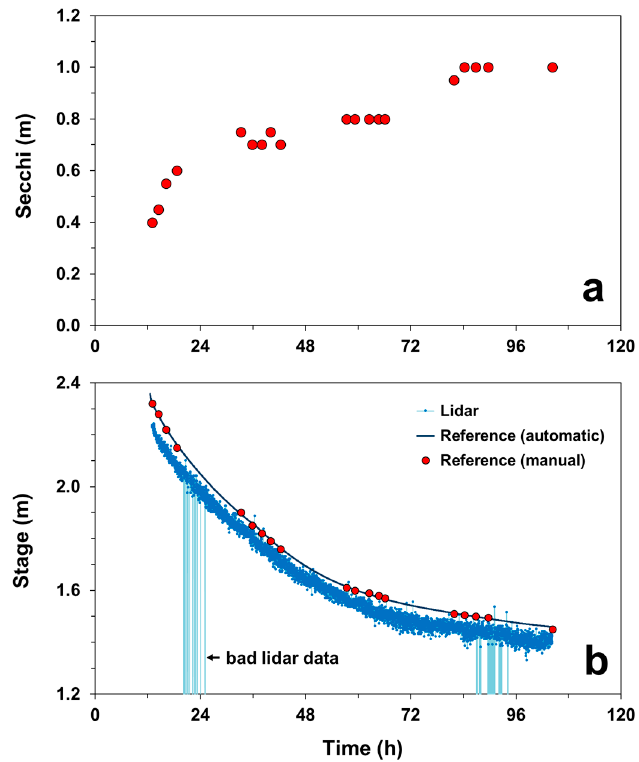
Figure 5. Laboratory test showing that a Lidar does not detect the surface of turbid water but rather the suspended particles that are below: ( a ) water transparency (Secchi depth) and ( b ) stage estimates as a function of time (time “0” corresponds to midnight). In this example, the Lidar was oriented with an incidence-angle of 60°, it was operating in the “first pulse” mode and the solid particles added to water were an Andosol material mixed with detergent.